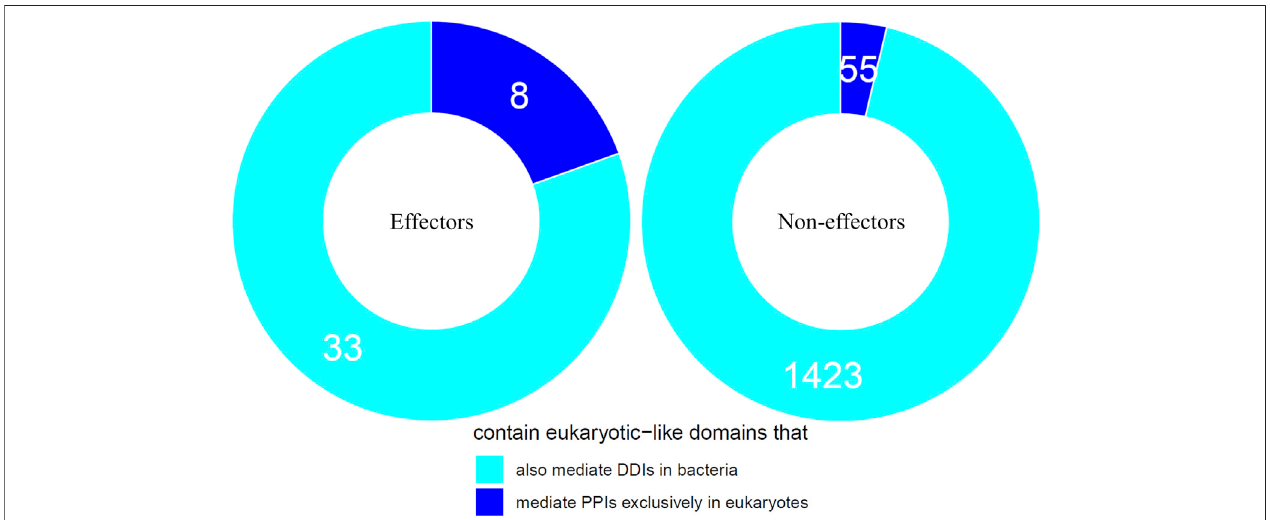
FIGURE 2 | Effectors are enriched for eukaryotic-like domains that mediate PPIs exclusively in eukaryotes. Among pathogen proteins containing domains that mediate experimentally veri fi ed PPIs in eukaryotes, 20% effectors and 4% non-effectors contain domains that mediate PPIs exclusively in eukaryotes, suggesting that effectors are six times as likely as non-effectors to repurpose eukaryote-speci fi c processes via eukaryotic-like domains (Fisher ’ s exact test, two-tailed p (cid:2) 2 * 10 − 4 ).